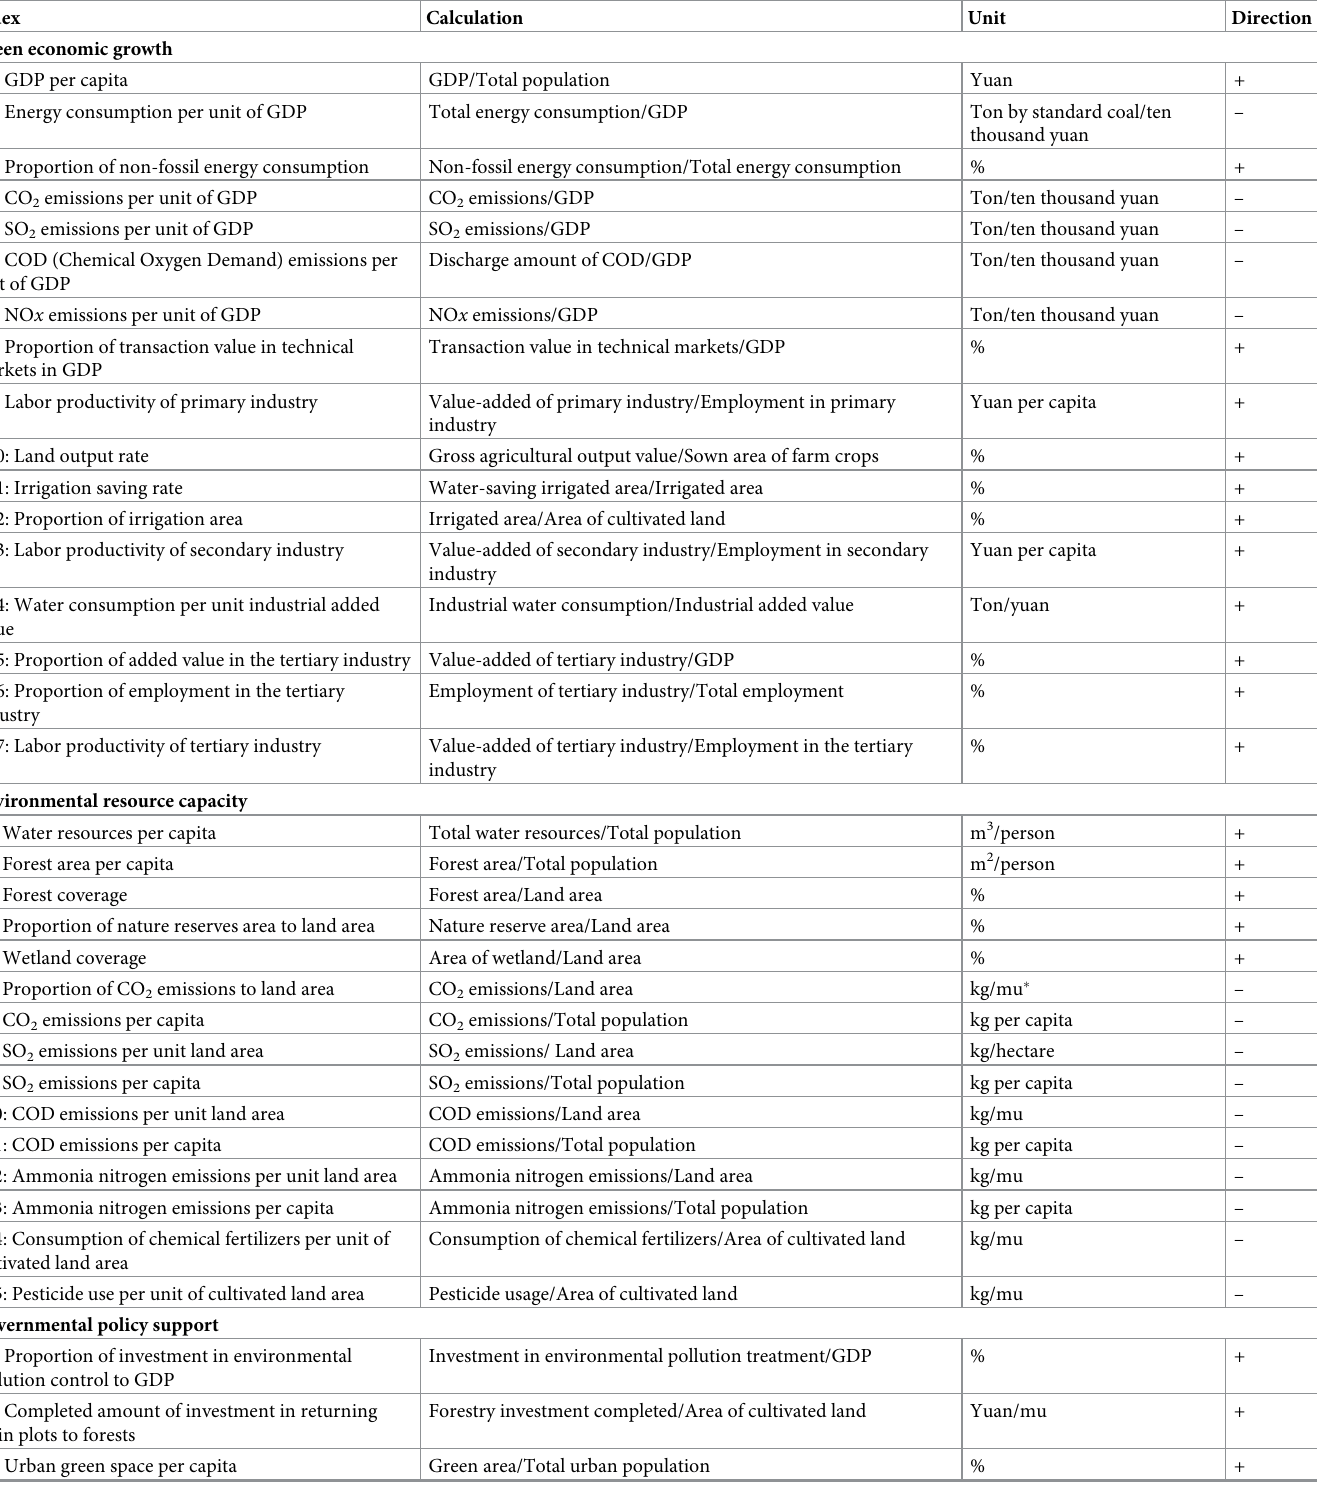
Table 1. Evaluation index system of China’s green